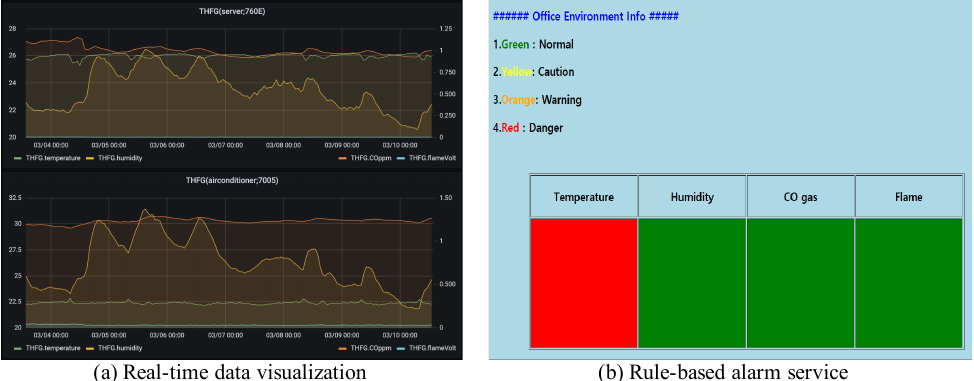
Figure 15. Examples of services using ScienceLoRa data. ( a ) Real-time data monitoring and ( b ) rule- based alarm